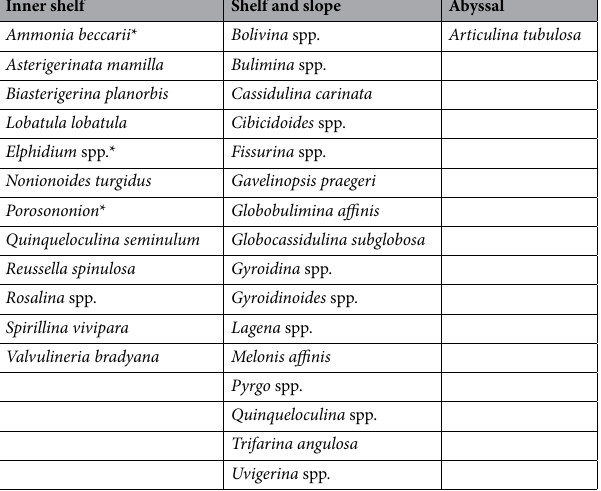
Table 2. Water depth distribution of the main benthic foraminifera in core samples. *Observed in cores Cala- 04 and CQ14_02. See the taxonomic reference list in Supplementary Material (SM6 and